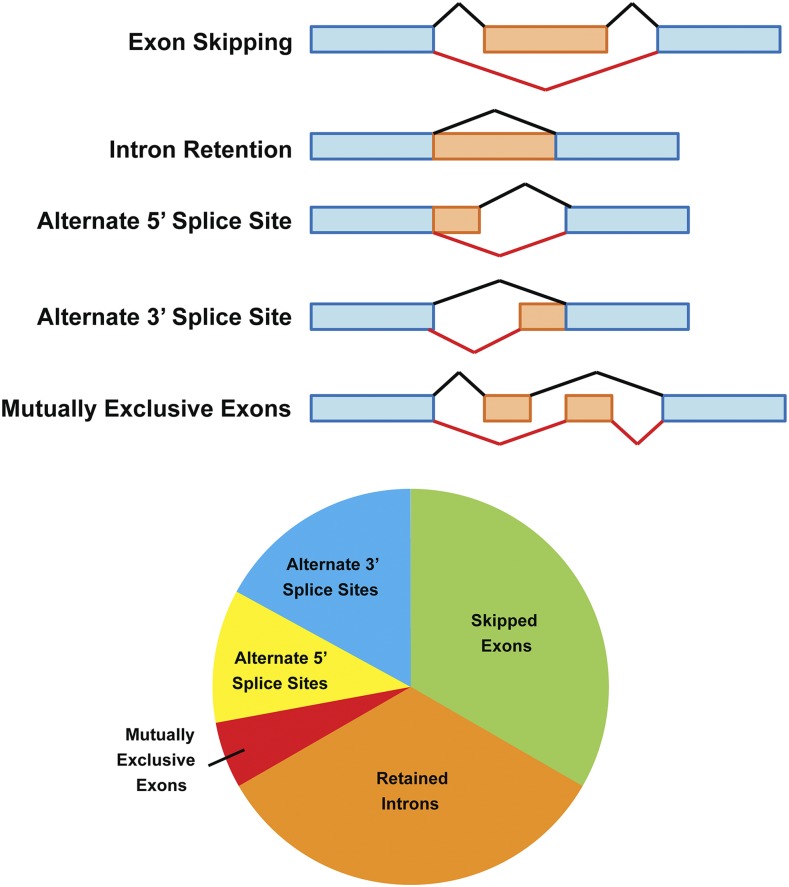
Inflammation induces multiple classes of alternative pre-mRNA splicing events in resident alveolar macrophages. MISO was used to identify alternative splicing in resident alveolar macrophages isolated from mice 3 days after LPS challenge compared to resident alveolar macrophages from untreated mice. Schematics at top depict the various classes of alternative splicing events. Black bars indicate the canonical splicing event; red bars and orange exons indicate the alternative pre-mRNA splicing event. The pie chart indicates the frequency of each class of alternative splicing event. Total N (number of alternative splicing events identified) = 276.